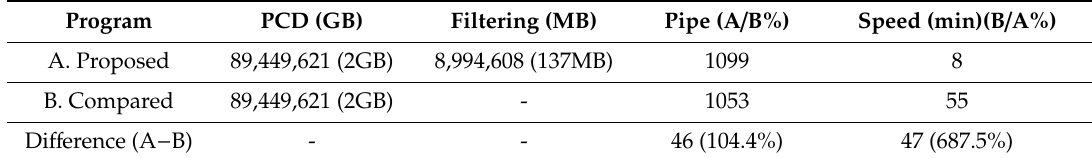
Table 7. Pipe object mapping performance